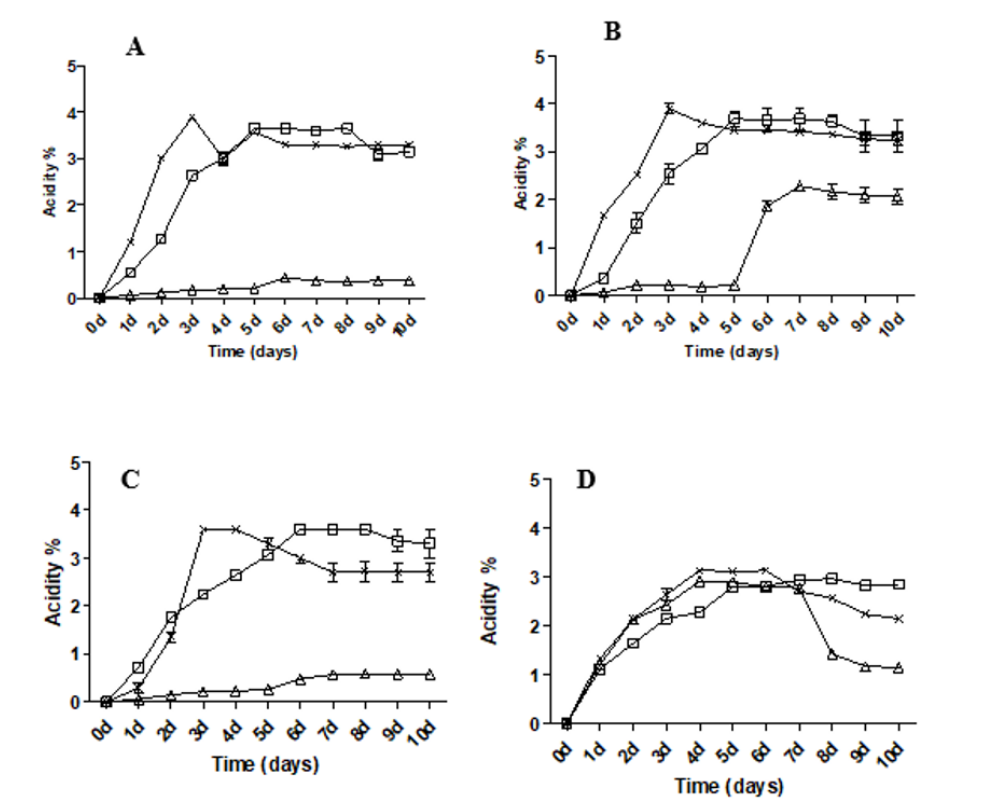
Figure 1: Comparison of acetic acid production of A. pasteurianus AB5 (A) PP21; (B) A. pomorum SC31; (C) with A. Pasteurianus SL13E-2 and (D) the reference strain at 30 ℃. (Squares), 36 ℃ (Crosses), and 37 ℃ (Triangles) with 4% initial ethanol